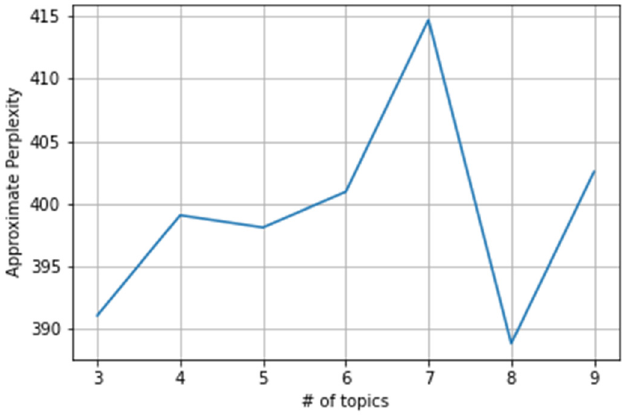
Figure 7. LDA topic confusion trend chart of the positive sentiment data set during the T4 period. After determining the optimal number of topics through the perplexity indicator, the weights of the topic terms and subject terms were output and the results of some of the runs are shown in Table 3. Partial running results of LDA topic model.